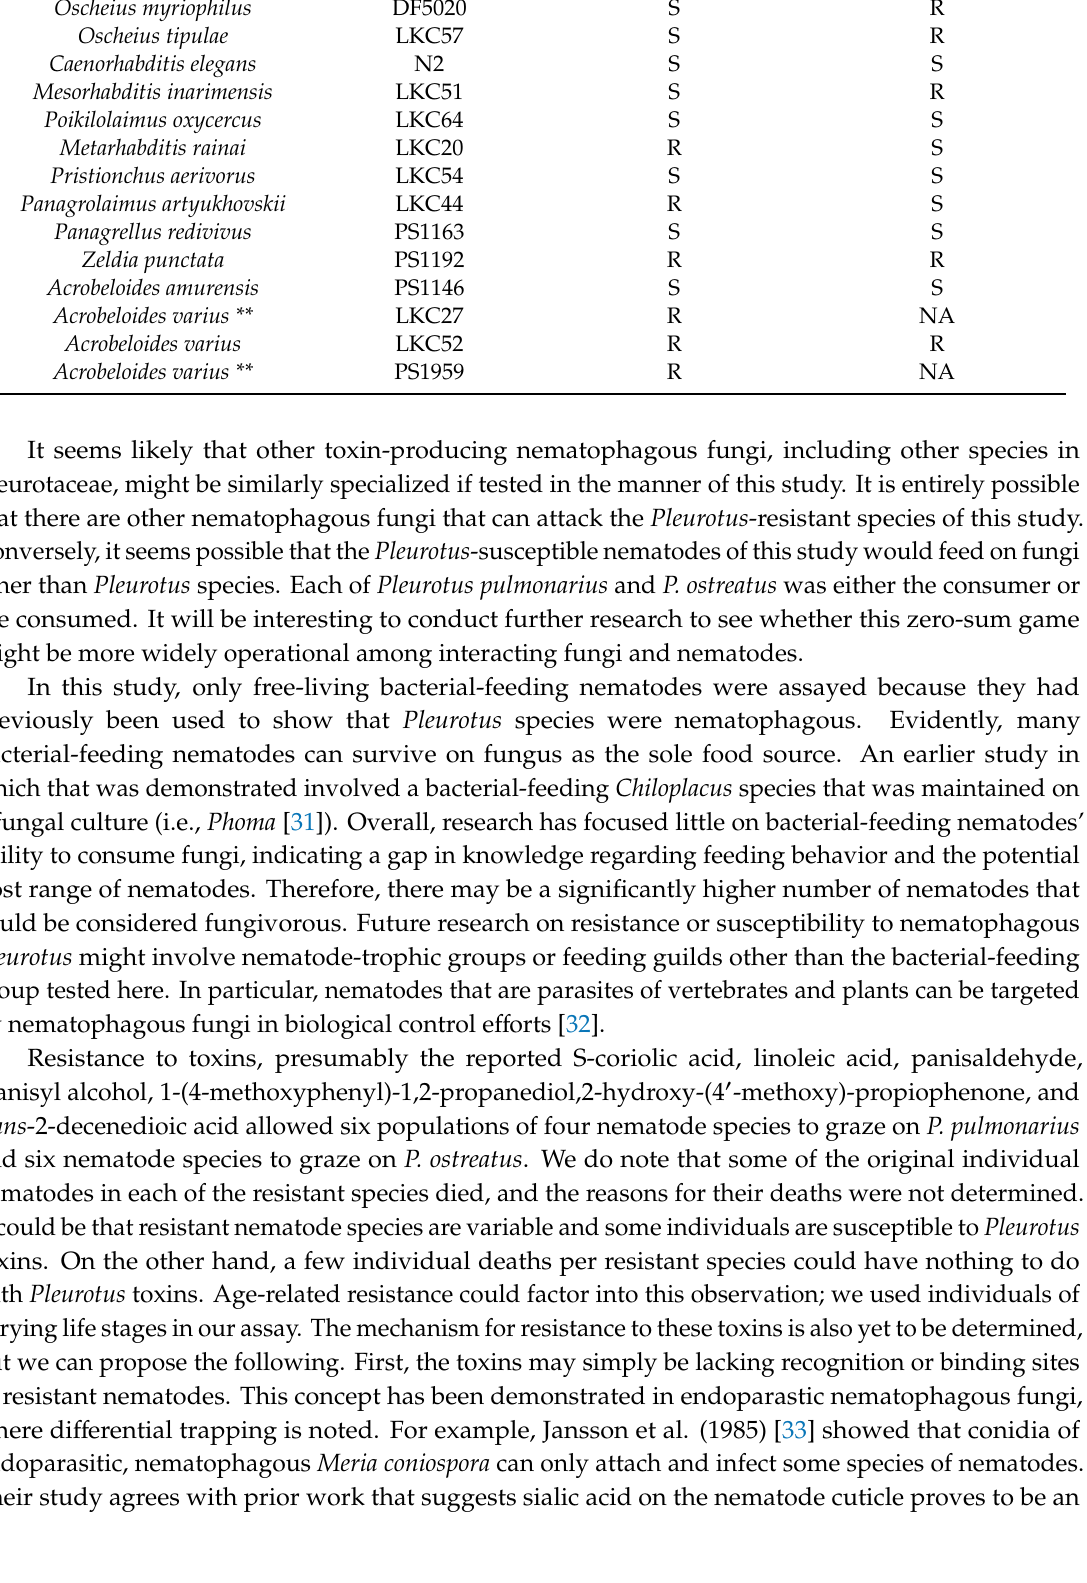
Table 3. Our results of bacterial-feeding nematode interactions with two species of Pleurotus grown on water agar. Nematode species revealed that the two species of Pleurotus were di ff erential interactors with all four sets of interactions across the row: SR, SS, RS, and RR. S = susceptible, R = resistant. Species Culture Isolate Pleurotus pulmonarius Pleurotus ostreatus Oscheius dolichura